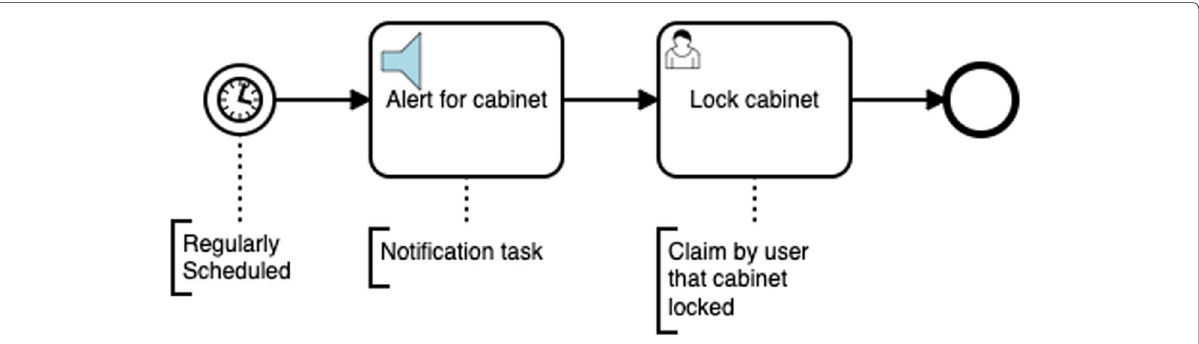
Fig. 6 Process for cabinet locking